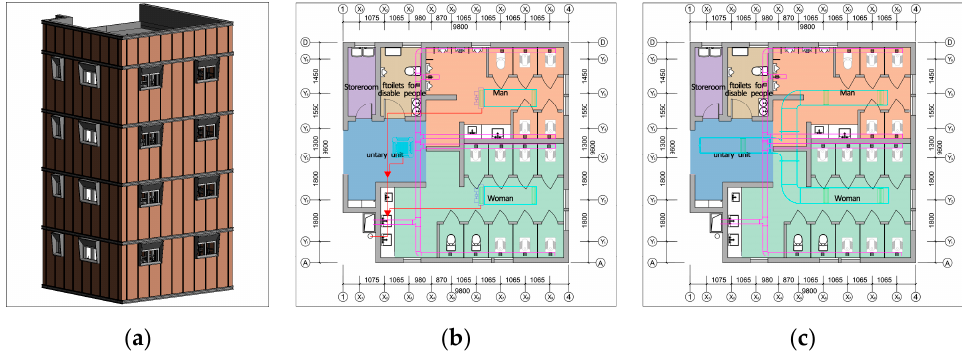
Figure 2. Three-dimensional view and layout of a typical floor of the public toilet facility. ( a ) De- scription of three-dimensional view; ( b ) Description of primary air fan–coil system; ( c ) Description of all-air air conditioning system.